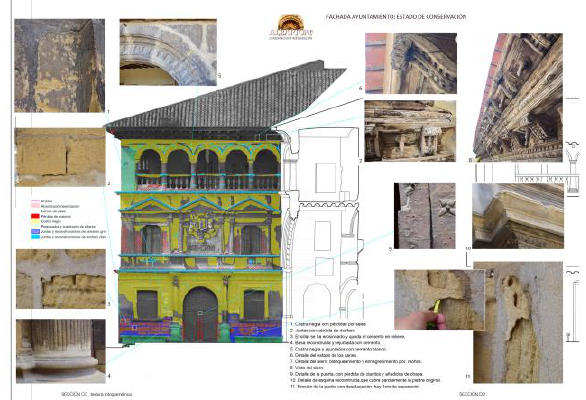
Figure 5. Resultados del informe arqueológico elaborado por Albarium S.L. Conservación y